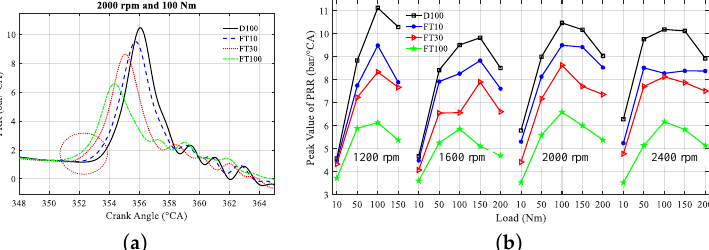
Figure 3. ( a ) PRR curves of all fuels under the condition of 2000 rpm and 100 Nm. ( b ) PRR peak value of all fuels under all test conditions.